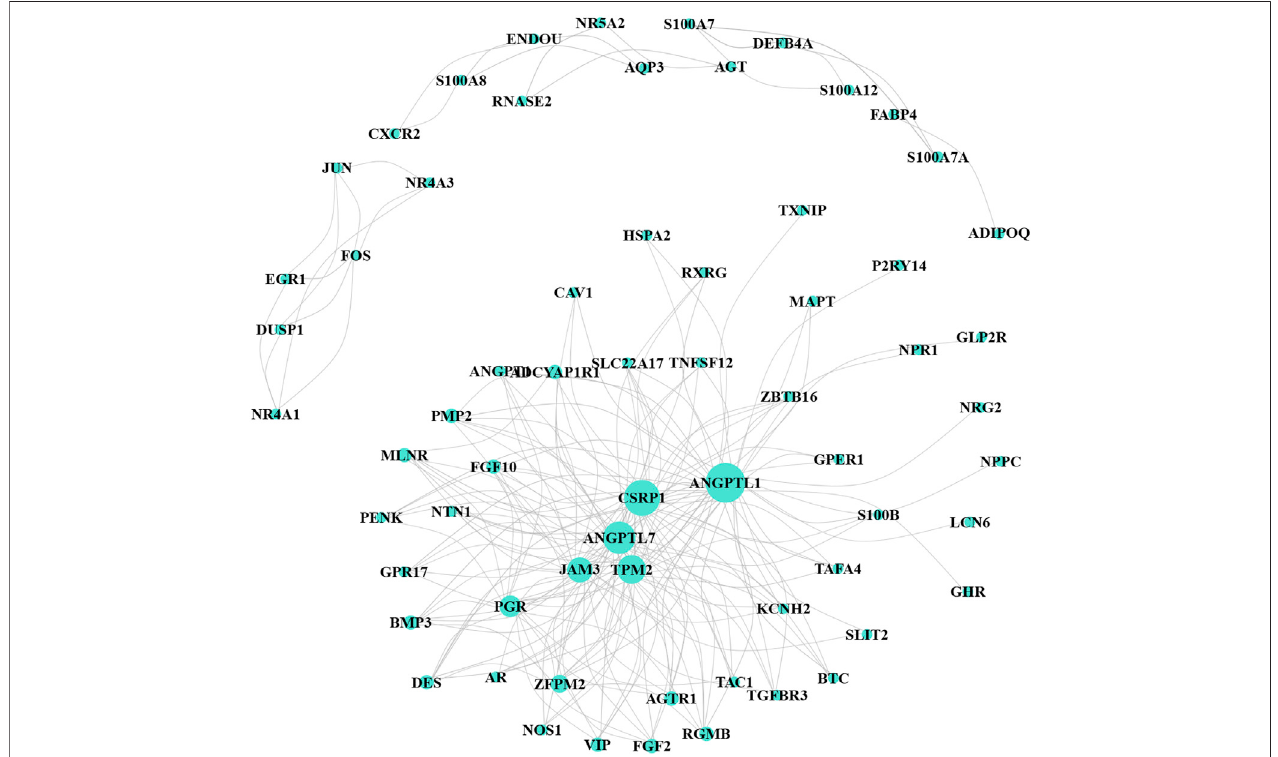
FIGURE 3 | Co-expression network for turquoise-module genes. The size of the node represents the number of interaction proteins; lines indicate